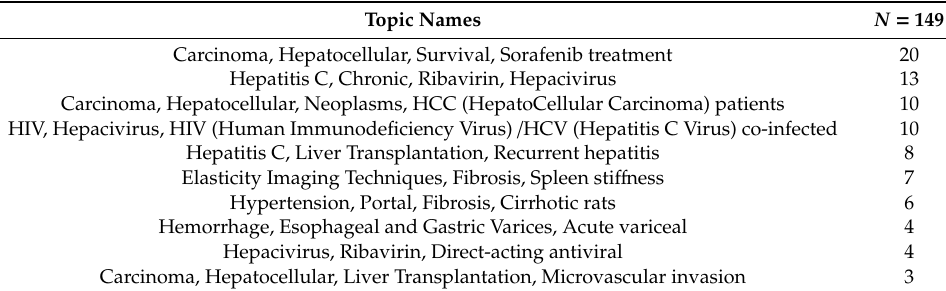
Table 11. Carcinoma. Cluster (6), weigh